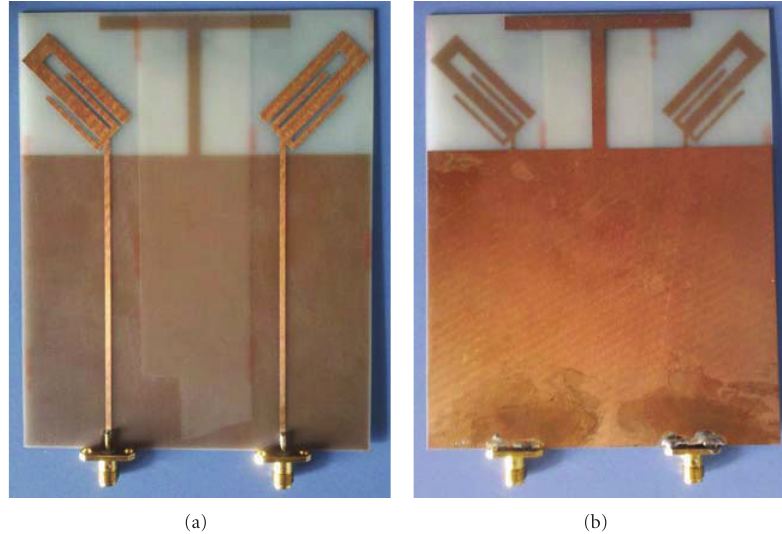
Figure 2: Photographs of the fabricated MIMO antenna.